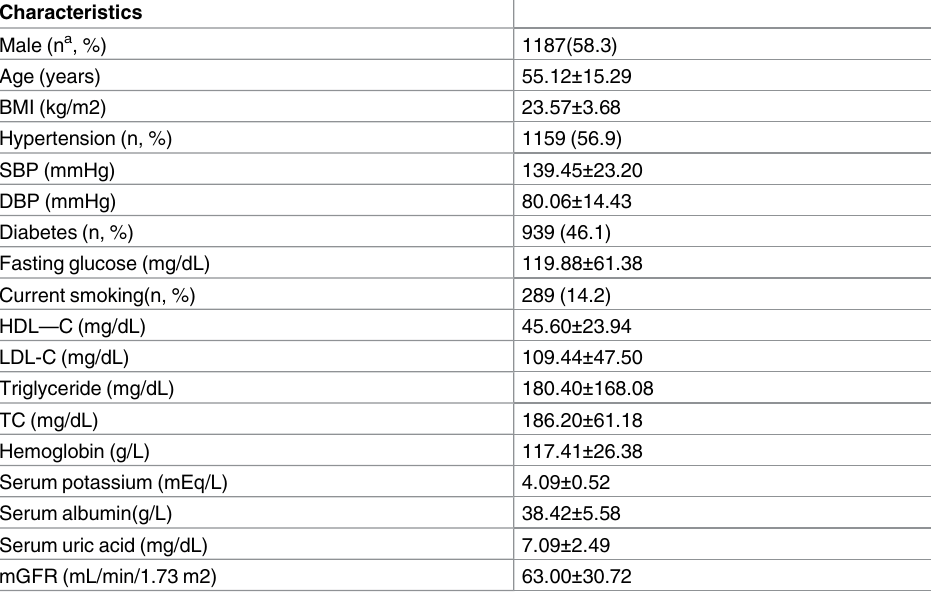
Table 1. Characteristics of the study participants. BMI indicates body mass index; SBP systolic blood pressure; DBP diastolic blood pressure; HDL—C high-density lipoproteincholesterol; LDL-C low-density lipoprotein cholesterol; TC total